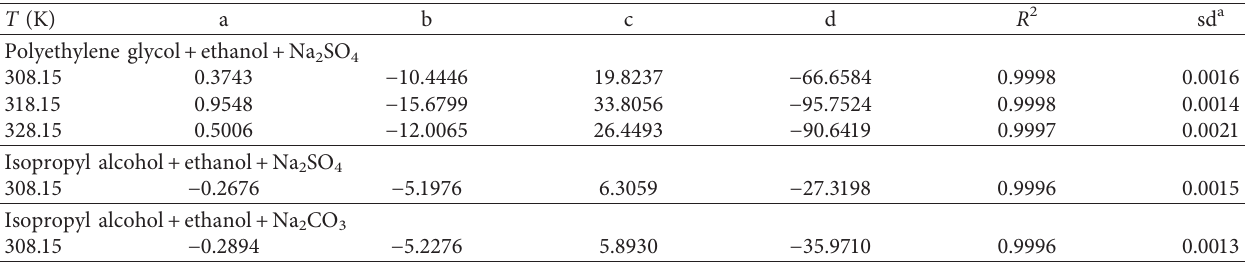
2 CO 3 /Na 2 SO 4 )+water